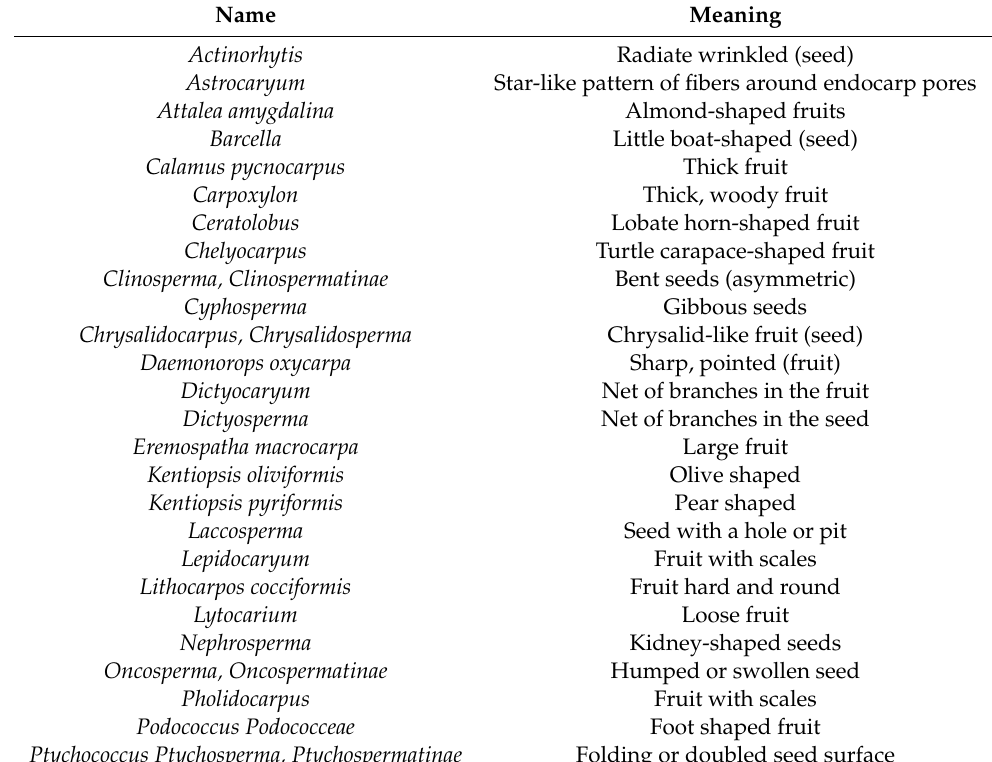
Table 2. Some of the names in the taxonomy of the Arecaceae are related to morphological characteristics of their fruits and